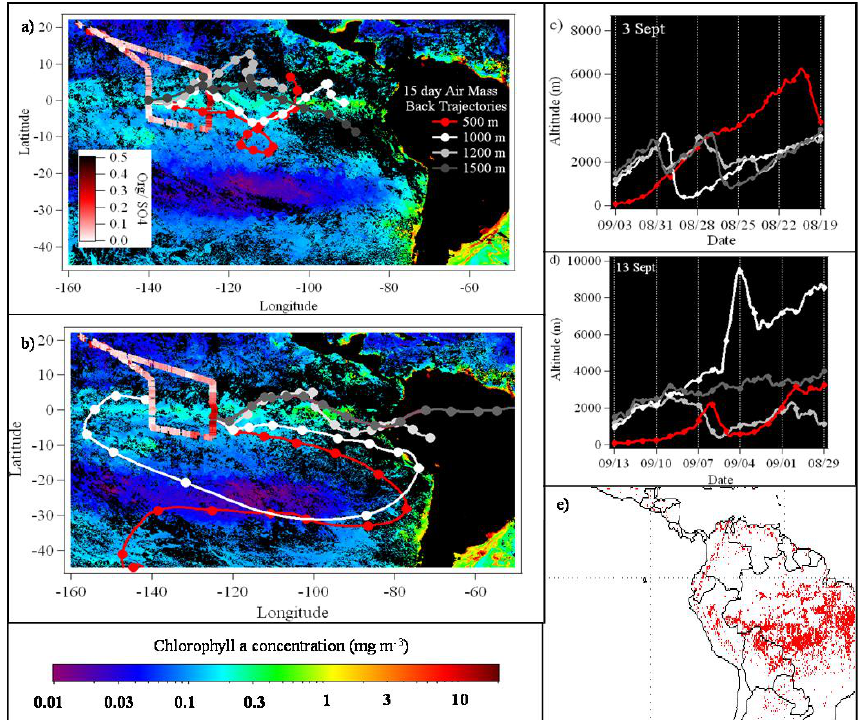
Fig. 9. SeaWIFS chlorophyll- a 8 day composite for periods (a) 29 August–5 September 2009 overlaid by AMBTs from 3 September 2009 and (b) 6 September–13 September 2009 overlaid by AMBTs from 13 September 2009. Cruise track is shown, colored by Org/SO 4 . AMBT altitude profiles are shown for (c) 3 September 2009 and (d) 13 September 2009. Altitude profiles are colored using the same legend as (a) . Panel (e) biomass burning events from 1 September–8 September 2009